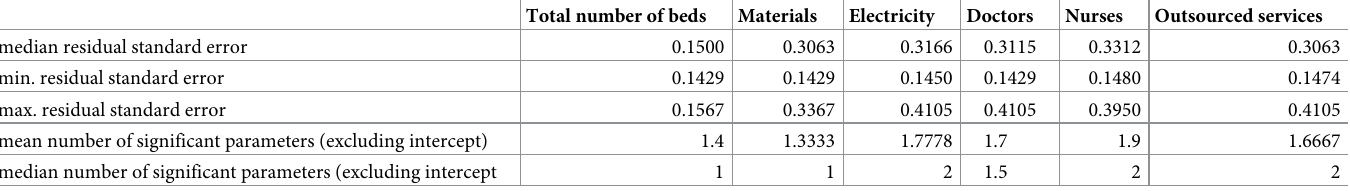
Table 3. Comparison of adjustment of three-factor Cobb-Douglas function by explanatory variables.